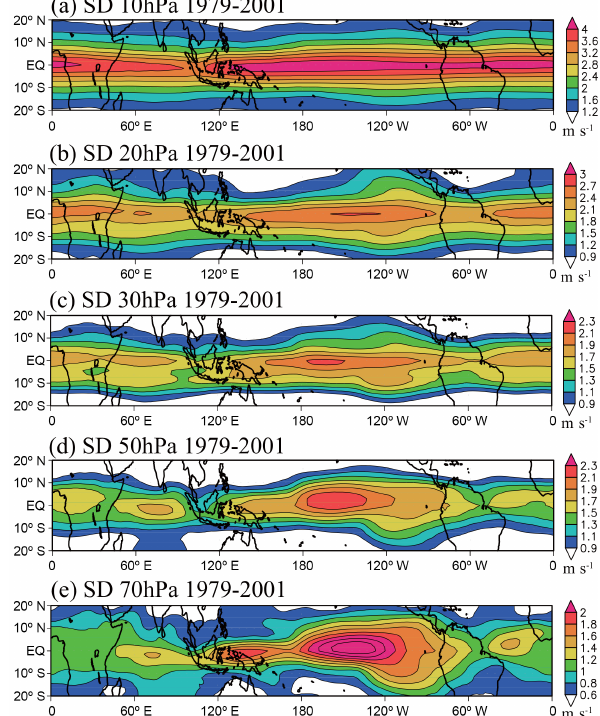
Figure 4. Horizontal maps of the standard deviation among the five reanalyses at (a) 10hPa, (b) 20hPa, (c) 30hPa, (d) 50hPa, and (e) 70hPa. The color intervals are 0.4ms − 1 for (a) , 0.3ms − 1 for (b) , and 0.2ms − 1 for (c–e) . Color ranges are different among these